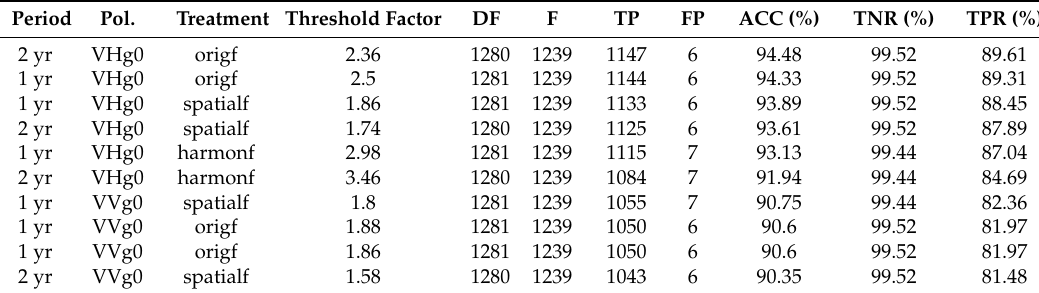
Table 7. Final results of the ALT detection with a fixed TNR~99.5% (0.5% of false positives), ordered by TPR. Only the 10 top results shown. DF = Number of deforested TS; F = Number of forest TS; TP = True positives; FP = False positives; TNR = True Negative Rate; TPR = True Positive Rate; ACC